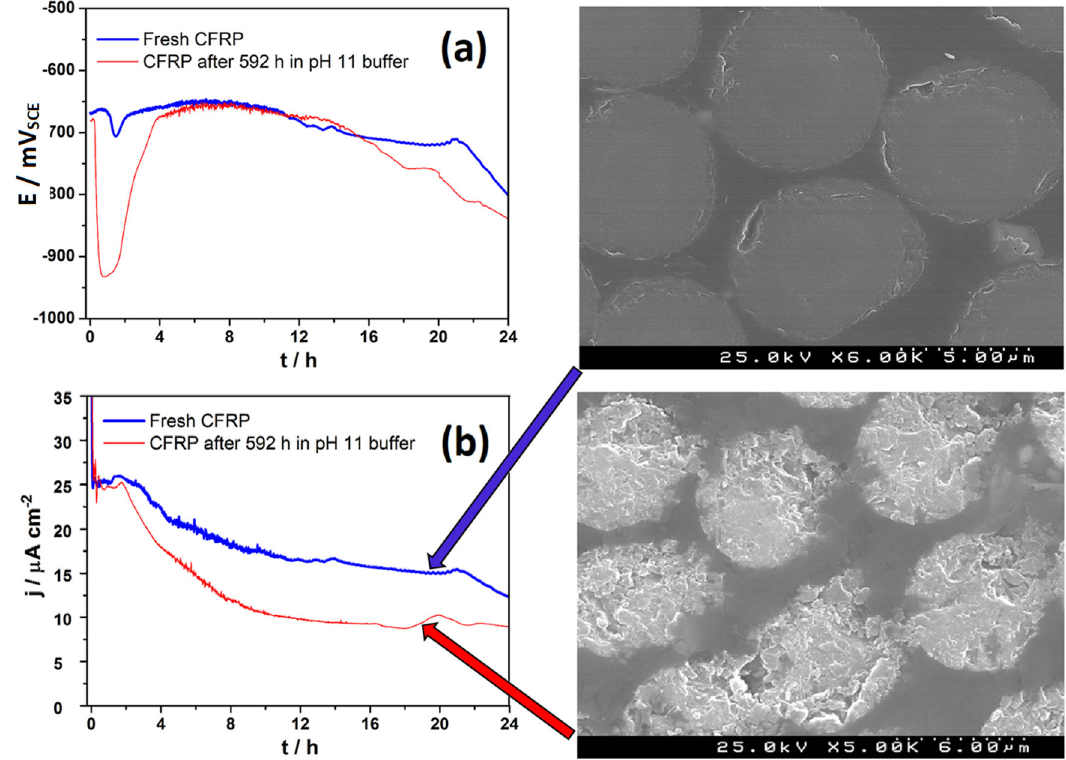
Fig. 13 Relationship between galvanic corrosion of Al-CFRP couples and condition of the CFRP surface. ZRA measurements of a potential and b galvanic current density pro fi les for Al-CFRP in 50 mM NaCl with freshly prepared CFRP surface and prior degraded CFRP sample, respectively (Inset are the SEM images of the fresh and degraded CFRP surfaces prior to ZRA measurements). Table 2. Deduced EASA based on GSA of CFRP sample and its 65% carbon fi bre content. Data treatment